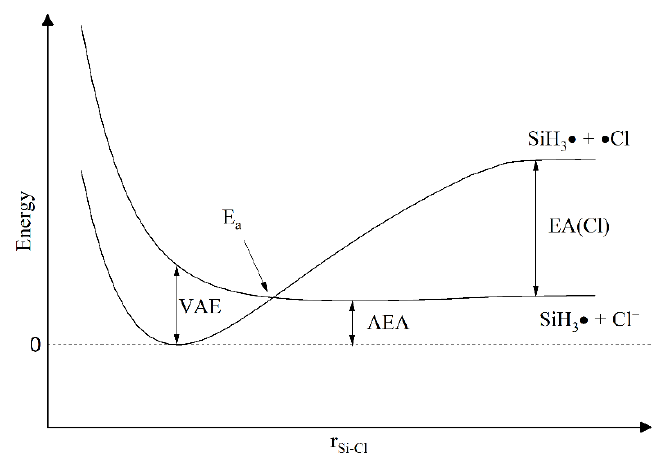
Figure 4. Potential curves for a SiH 3 Cl molecule and its negative ion.